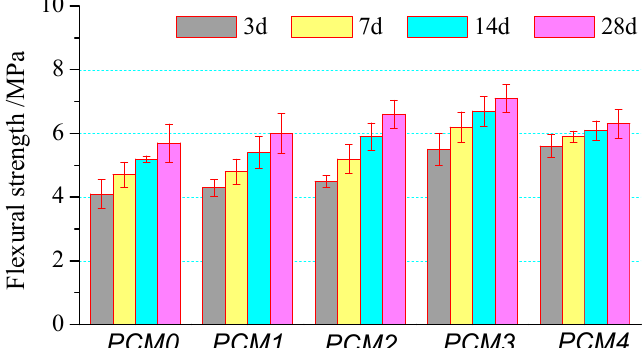
Figure 5. E ff ects of PVA content on the flexural strength of cement mortar. Figure 5. Effects of PVA content on the flexural strength of cement mortar.